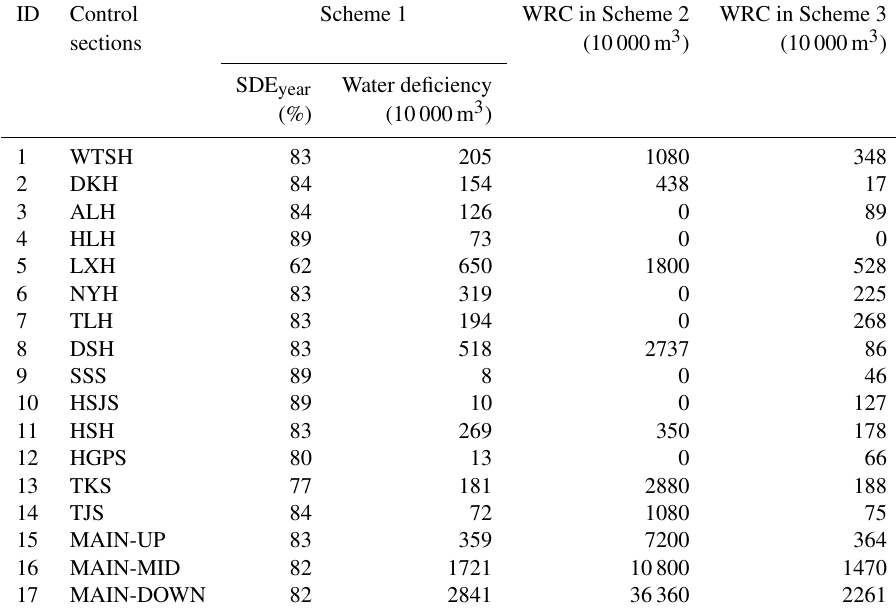
Table 4. SDE and WRC under three E-WAS schemes in a typical dry year ( P = 75%).